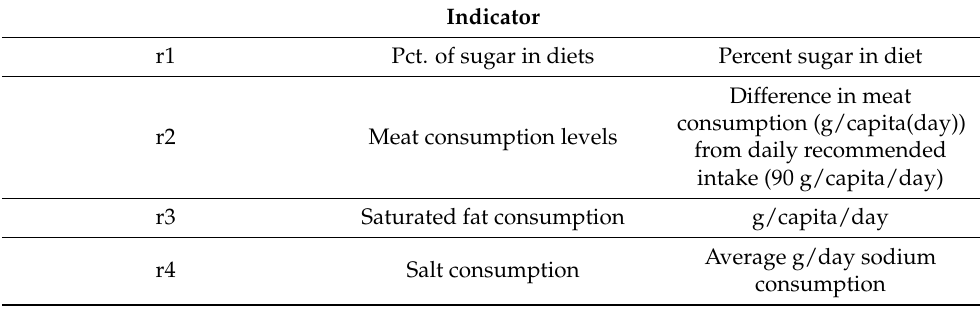
Table 10. Indicators of the food sustainability study.